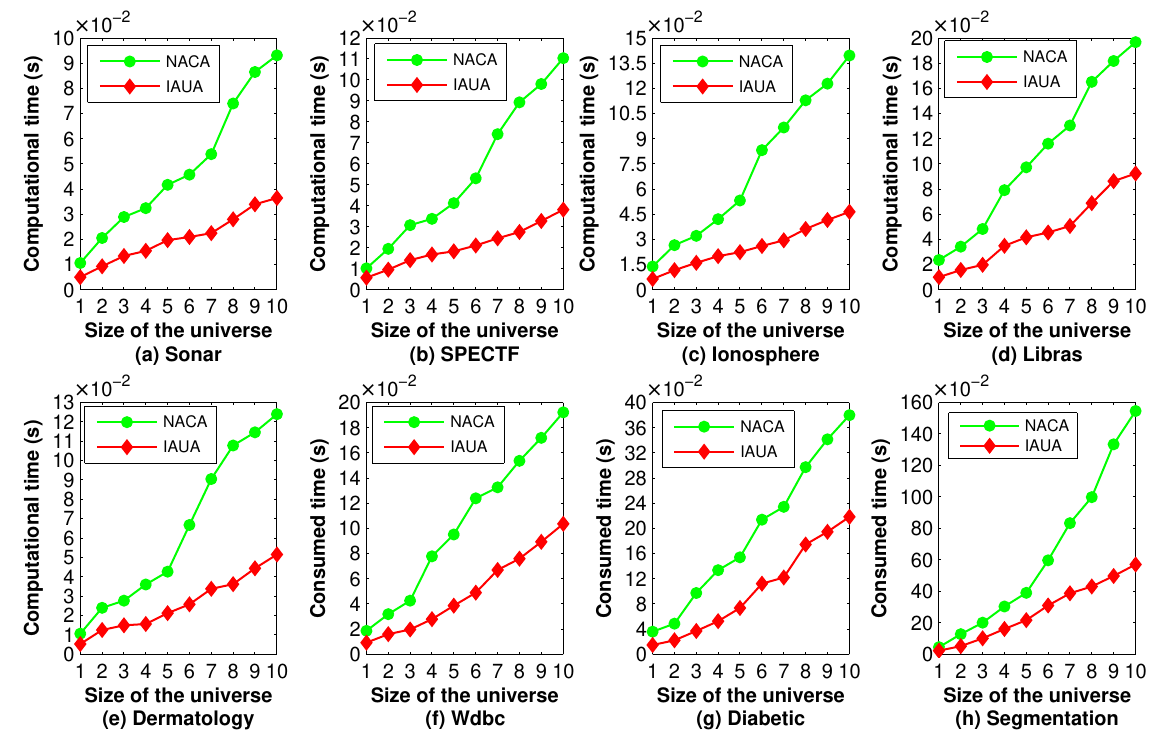
Figure 1. A comparison of NACA and IAUA with different sizes of